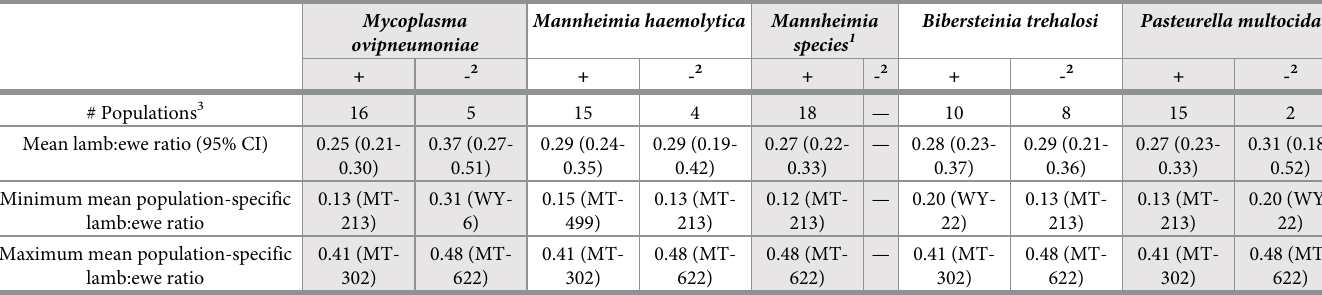
Table 3. Model-estimated lamb:ewe ratios and pathogen detection status in 21 bighorn sheep populations.